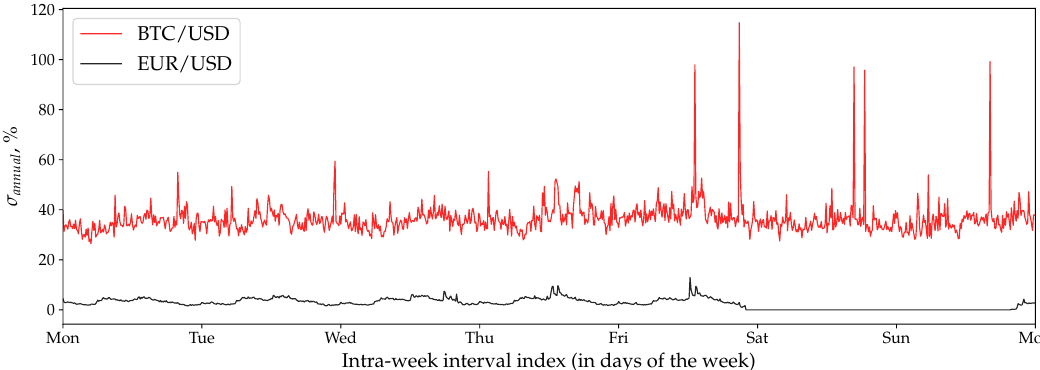
Figure 8. Realised volatility seasonality patterns of BTC/USD and EUR/USD exchange rates computed using the traditional approach (Equation (20)). Time intervals of 1-min have been used to calculate returns. The size of each bin is 10 min, there are 1008 bins in